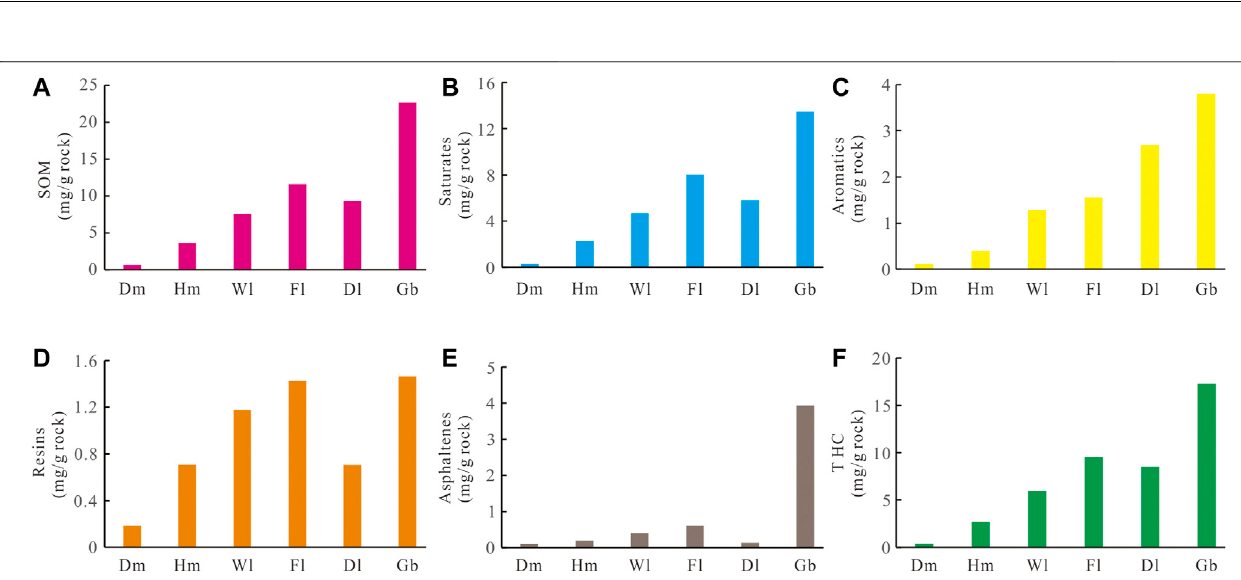
FIGURE 7 | Average absolute contents of SOM and group components in shales with different lithofacies.